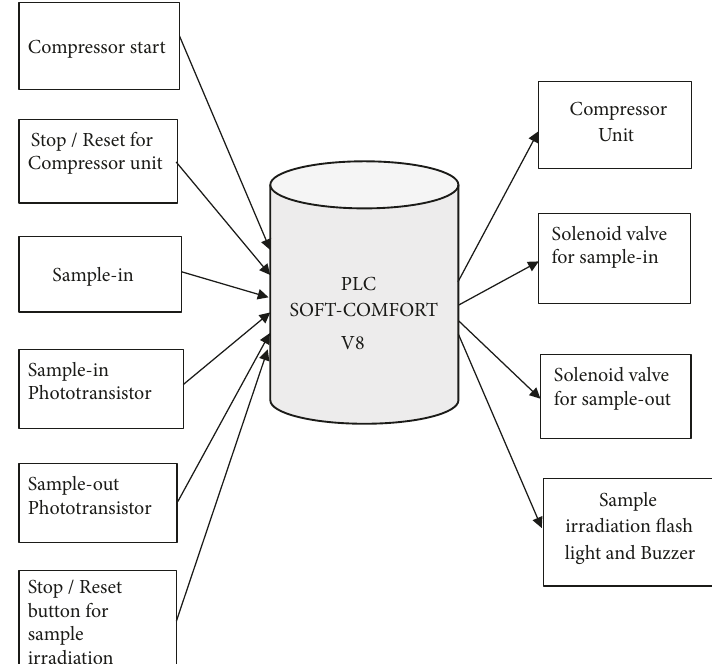
Figure 5: Context analysis diagram of PTS controller unit